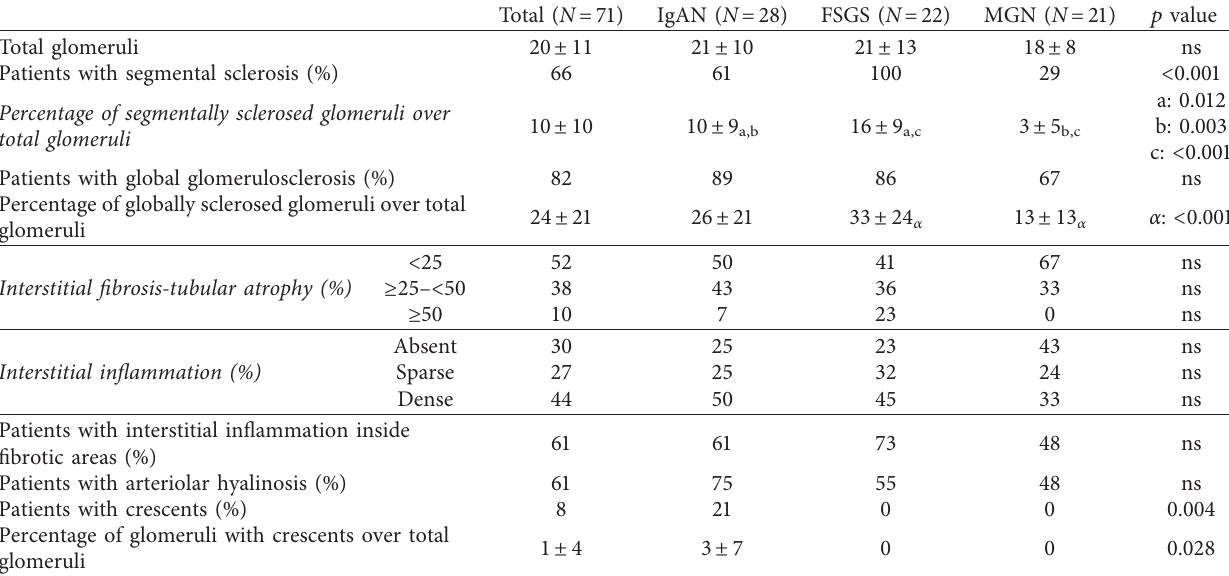
Figure 1: Stacked bar chart of Oxford classification parameter frequencies in patients with IgA nephropathy. Mesangial hypercellularity was almost equally scored as M 0 ( < 50% of glomeruli showing mesangial hypercellularity) and M 1 ( > 50% of glomeruli showing mesangial hypercellularity); endocapillary hypercellularity was more frequently scored as E 0 (no endocapillary hypercellularity) than E 1 (any glo- meruli showing endocapillary hypercellularity); absence of segmental sclerosis ( S 0) was observed less than the presence of segmental sclerosis ( S 1); and 50% of patients showed interstitial fibrosis 0–25% ( T0 ), 43% had interstitial fibrosis 26–50% ( T 1), and only 7% had interstitial fibrosis > 50% ( T 2). Table 2: Light microscopy histological